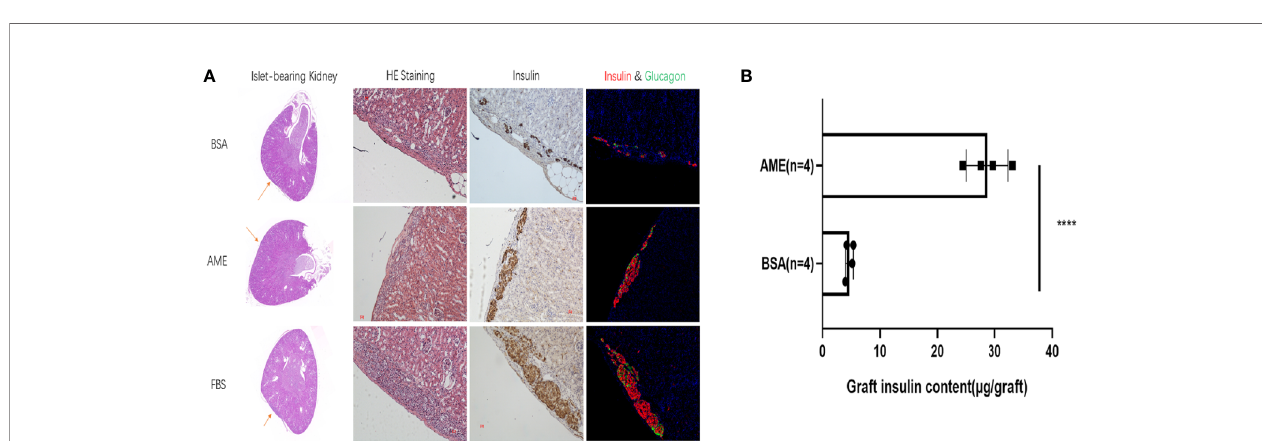
FIGURE 8 | Histological analysis of islet graft and islet graft insulin content assay (A) . HE, immunohistochemistry, and immuno fl uorescence staining of islet grafts. Scale bar: 20 m m (B) . Islet grafts were harvested and homogenized to obtain the total insulin content of the grafts (****p < 0.0001 when BSA + AME [N = 4] group was compared to BSA only [N = 4], Unpaired t-test).